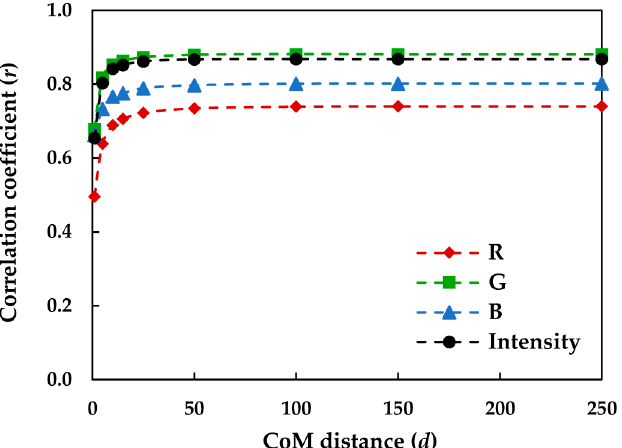
Figure 12. The correlation between the VRS Cpx of the textiles and Entp CoM of the textile images in the sRGB space improves by increasing the CoM distance ( d ) up to the certain value of d = 100 pixels, after which the correlation coefficient ( r ) remains almost unchanged.